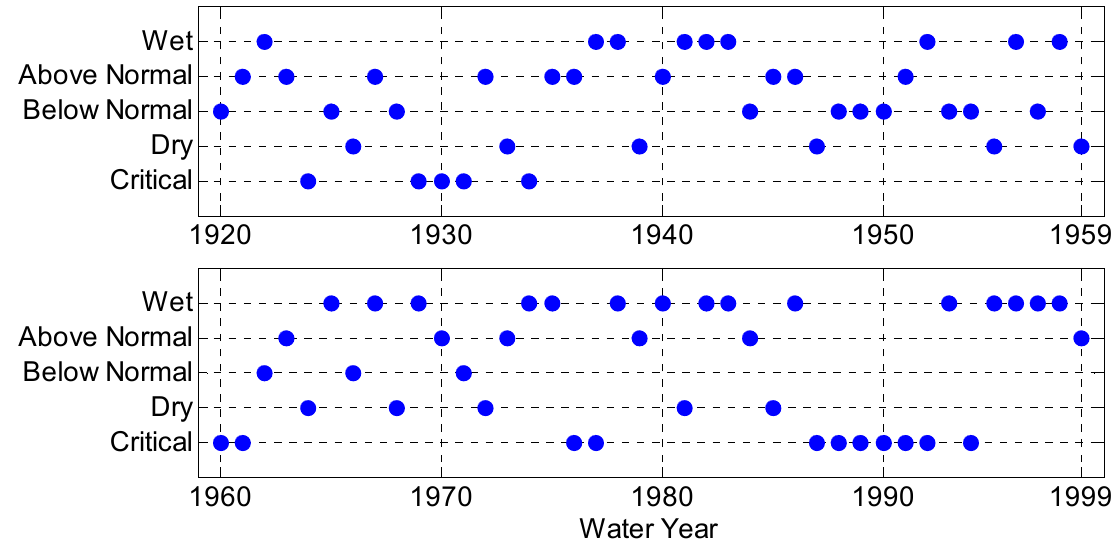
Figure A1. Historical water year type classification in the Sacramento River region.